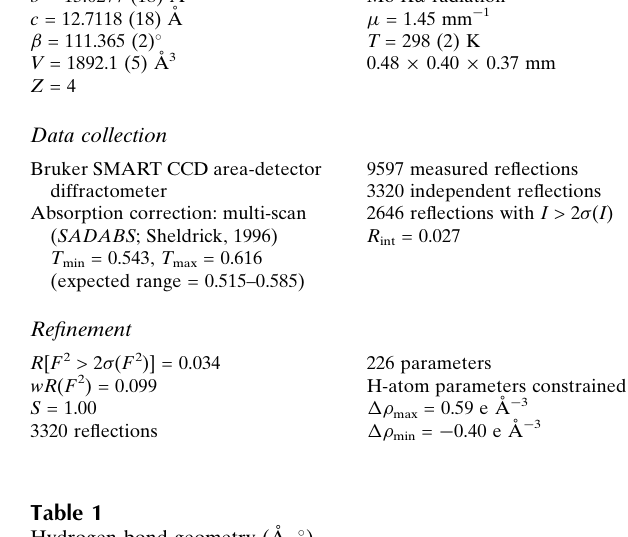
Hydrogen-bond geometry (A˚ , (cid:1)